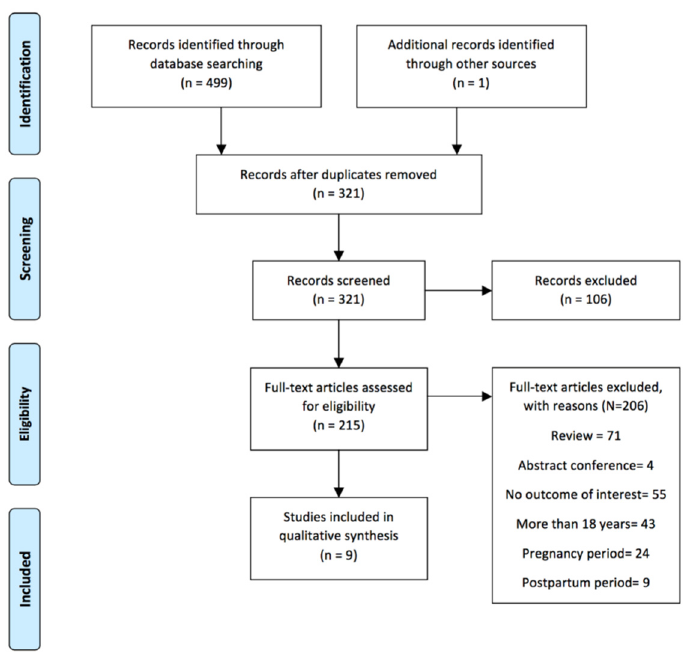
Figure 1. Flow diagram for the study selection.